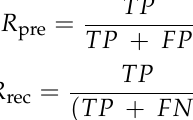
Figure 11. Fault identification results of different models. ( a ) SVM. ( b ) BPNN. ( c ) KNN clustering.